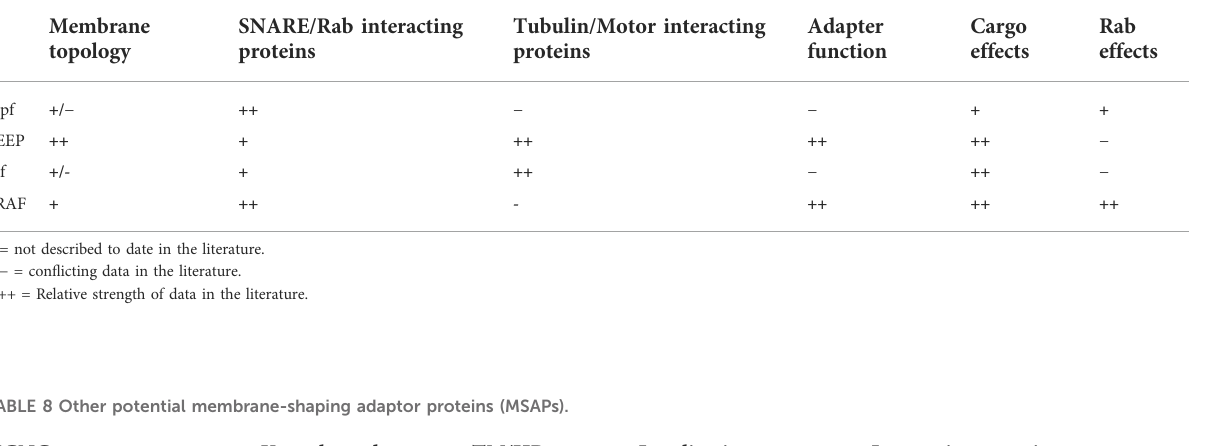
TABLE 7 Summary of known Yip family member biochemical and cellular properties.